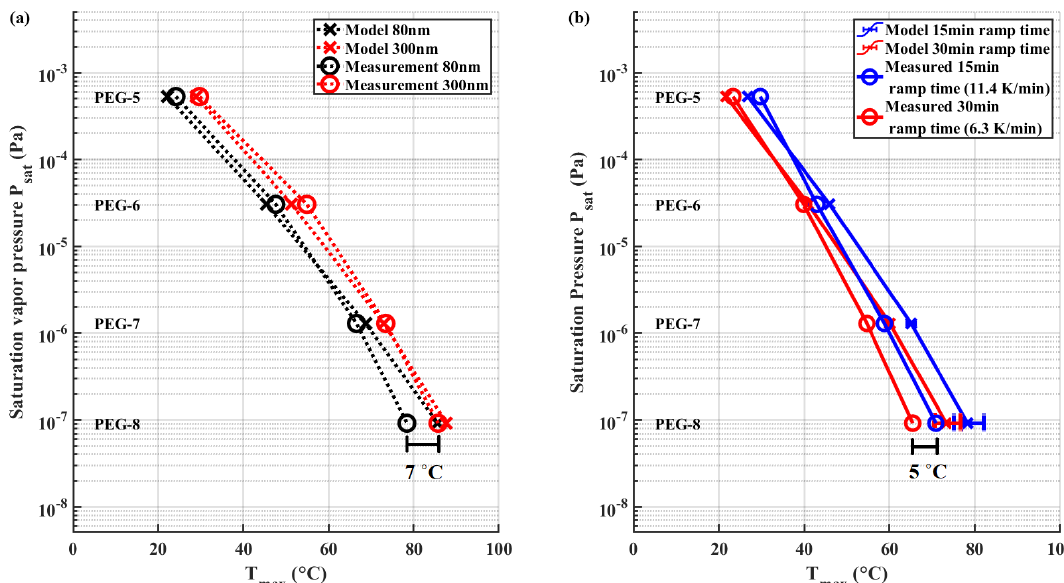
Figure 7. (a) T max values measured for 80 and 300nm particles with ramp time of 15min. The difference in T max between the two particle sizes is ∼ 7 ◦ C. Panel (b) shows measured T max values of 15 and 30min ramping times using polydisperse aerosol particles. The difference between the two heating rates is ∼ 5 ◦ C. Error bars are omitted from the measured values in the figure for sake of clarity. In panel (b) whiskers show the range of model results when using uncertainties of evaporation enthalpy shown in Krieger et al. (2018). The SDs for all measured points in (a) are between 0.2–0.5 ◦ C. In panel (b) the SDs for measured points are between 0.2–1.3 ◦ C.